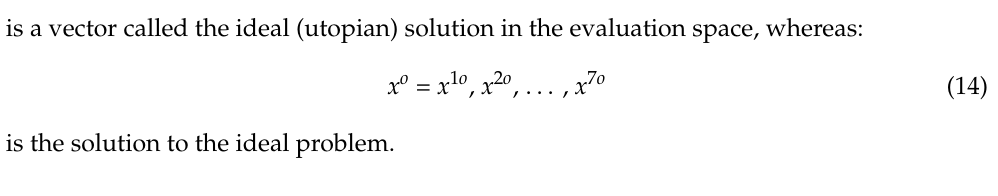
Table 11. Results of one-criteria problem f i ( x